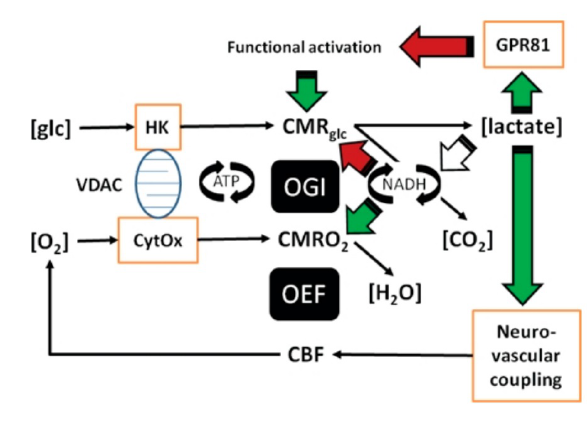
Fig. 2 EE and substrate metabolism of subjects at different ages. EE, energy expenditure